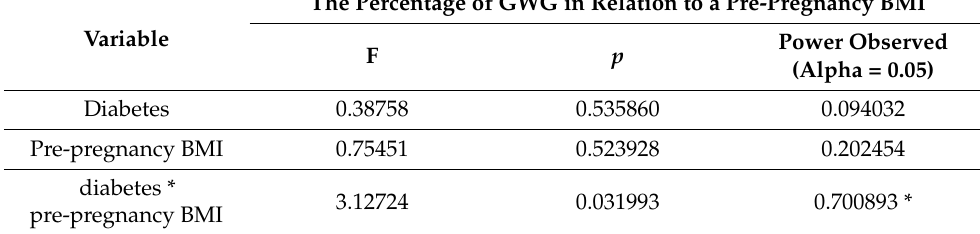
Table 3. The percentage of GWG in relation to a pre-pregnancy BMI.